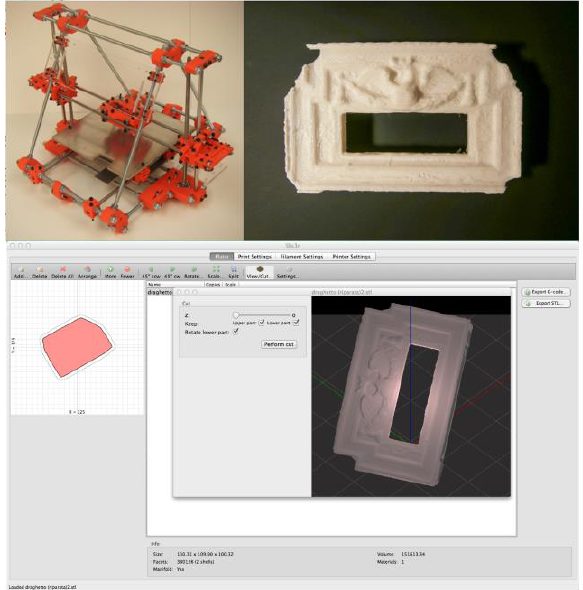
Figure 13. Slic3r: layering the model for RepRap print Printing was executed with a RepRap 3d printer, the first of the low-cost 3D printers (open source project), the total cost of the printing has been of 15 euros for a model in scale 1:10.